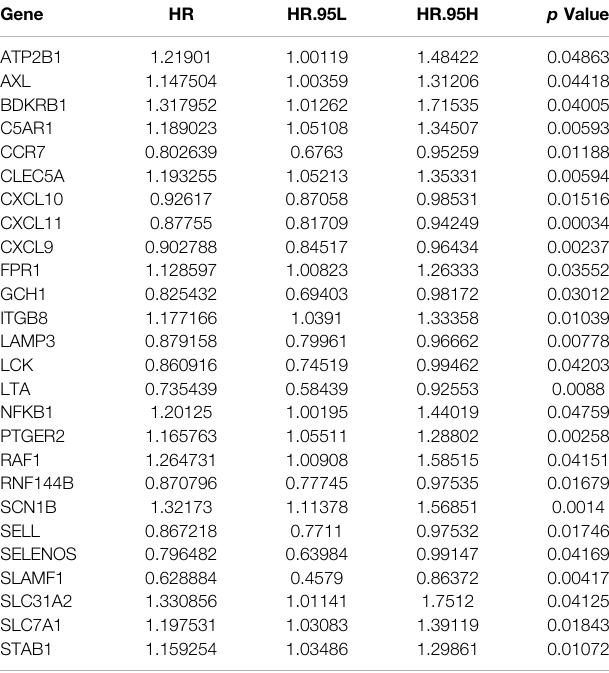
TABLE 1 | Identi fi cation of prognostic immunologically relevant genes across OC patients. Gene HR HR.95L